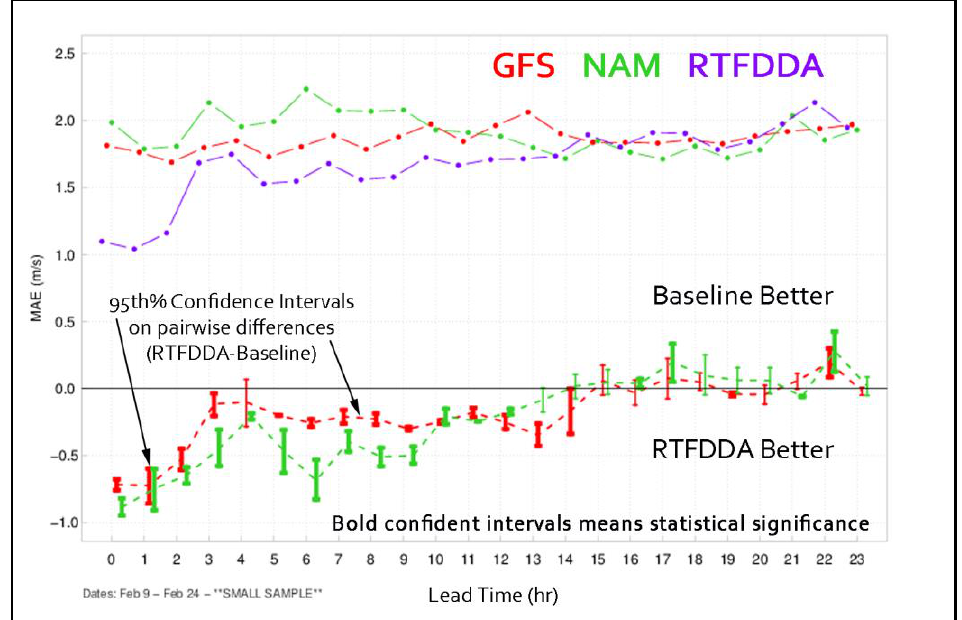
Figure 3. Comparison of the performance of RTFDDA with baseline numerical weather prediction (NWP) models. MAE: mean absolute error.